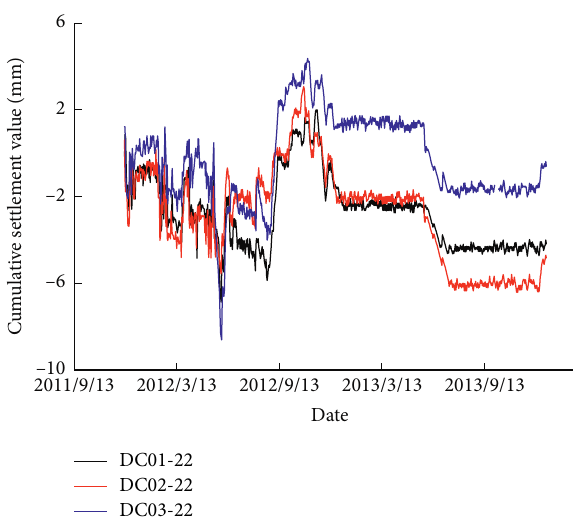
Figure 5: Settlement change curve of the construction company DC01-22 ∼ DC03-22 at Wannianquan Road Station.